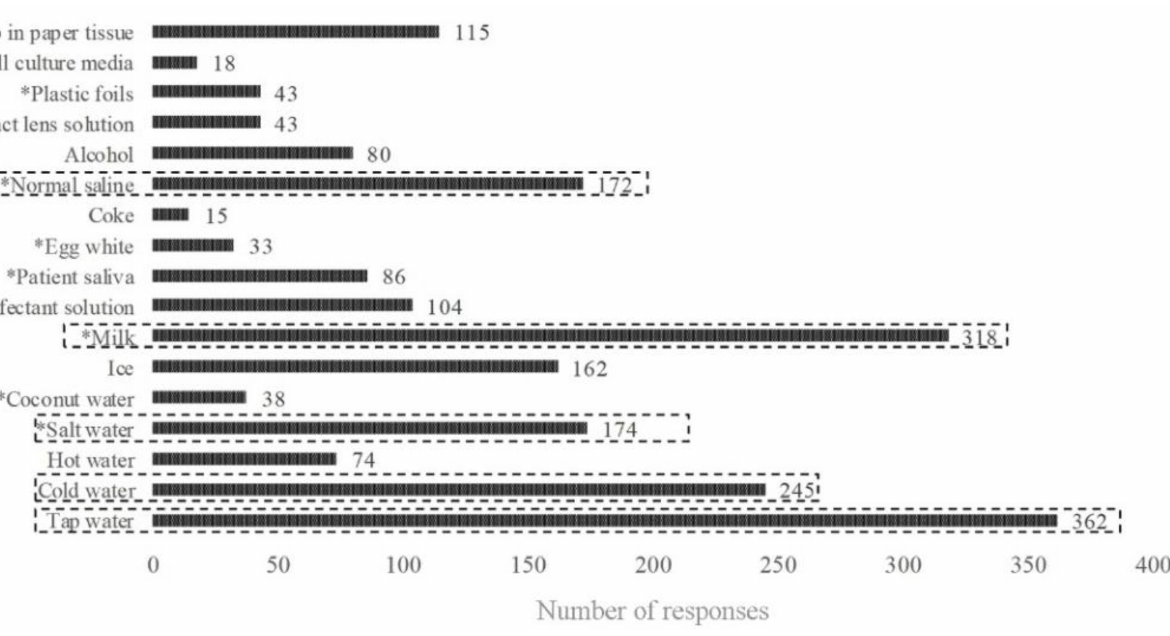
Figure 1. Frequency responses of the students to the question about the storage media of the avulsed tooth. The five most frequently selected media are emphasized. * correct answer. Table 4. The students’ attitudes about emergency management of traumatic dental injuries according to school sector